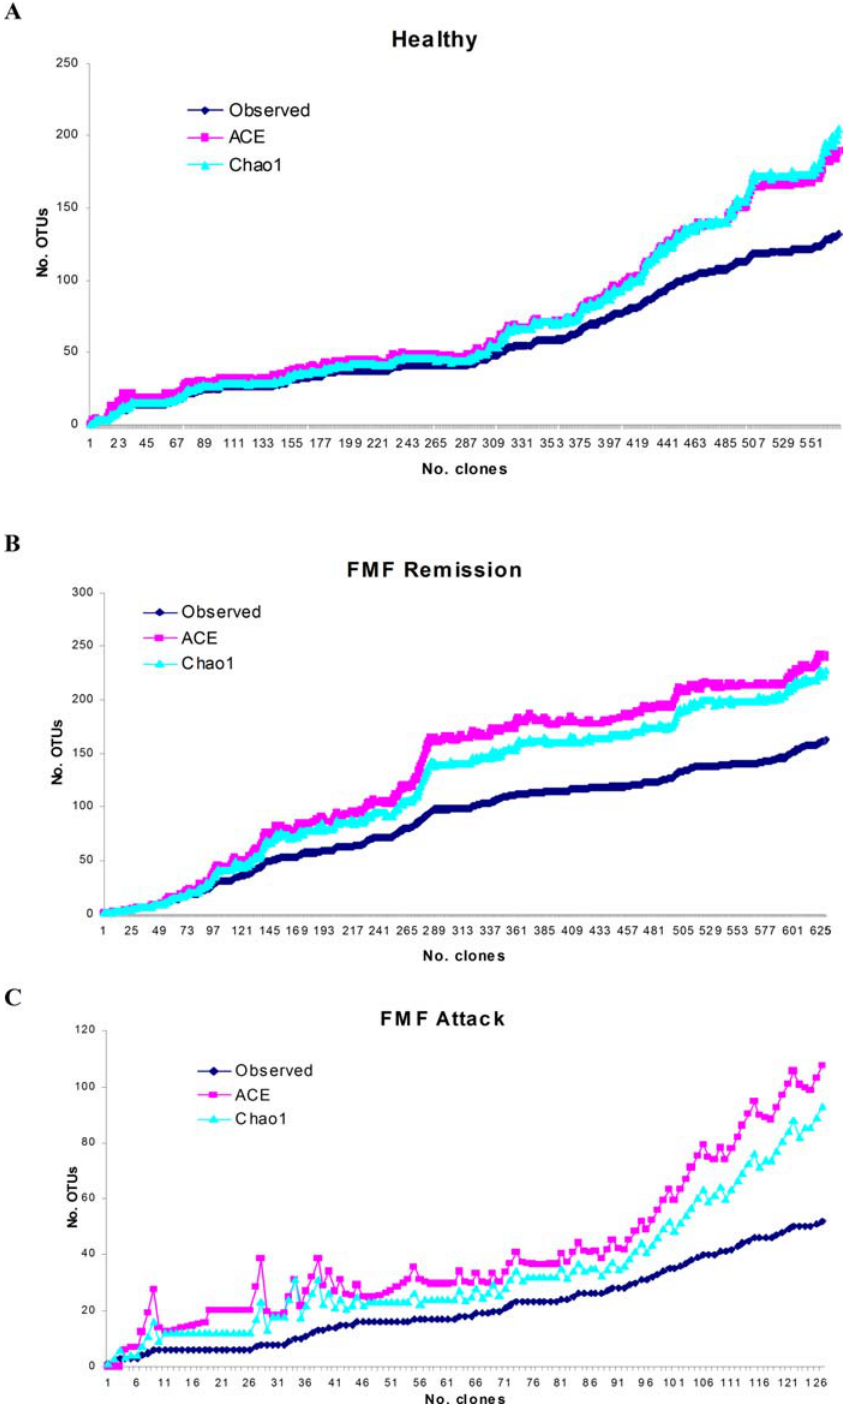
Figure 2. Collector’s curves of the observed and estimated phylotype richness of 16S libraries. Collector’s curves of the observed (shown in dark blue) and estimated (Chao1 (light blue) and ACE (red)) phylotype richness calculated for healthy subjects (A), FMF remission (B), and FMF attack (C) with the phylogenetic depth defined at 99% level. doi:10.1371/journal.pone.0003064.g002 proportion of cluster XIVa bacteria was only increased in the acute attack phase of the disease in comparison with controls and phase of the disease in comparison with the control group and remission (Fig. 3C). The proportion of ruminococci was significantly remission (Fig. 3A). The fraction of E. rectale-Roseburia cluster among lower in FMF patients (Fig. 3D), while no significant differences total bacteria was substantially increased, especially in active disease were detected among F. prausnitzii , bifidobacteria, lactic acid (Fig. 3B), while bacteria of cluster IX and Atopobium decreased in the bacteria, and enterobacteria (Fig. 3B, 3D and 3E).